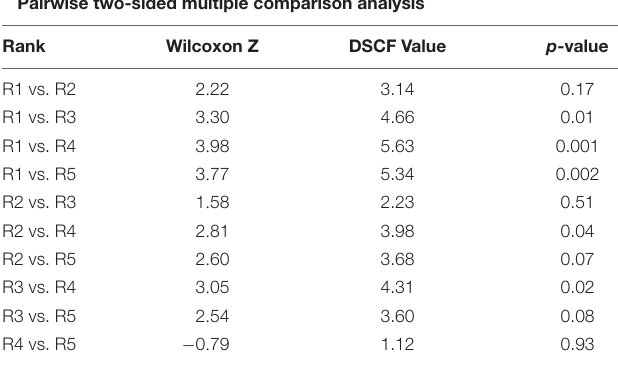
FIGURE 5 | Box whisker plot of adjusted modeled biogenic habitat provisioning scores, separated by 5 ranks from video observations. The y -axis shows the numeric model scores with the alphabetized classes A–F. Error bars show the maximum and minimum biogenic habitat provisioning score for each video rank, dark-gray and light-gray boxes show the 25% and 75% quartiles respectively, away from the median line. Lowercase lettering at the top of the figure, w–z, indicates significant differences between rank classes based on the Dwass, Steel, and Critchlow—Fligner Method. TABLE 2 | Comparison of the variation in modeled biogenic habitat scores by rank group for original and corrected data. Biogenic habitat